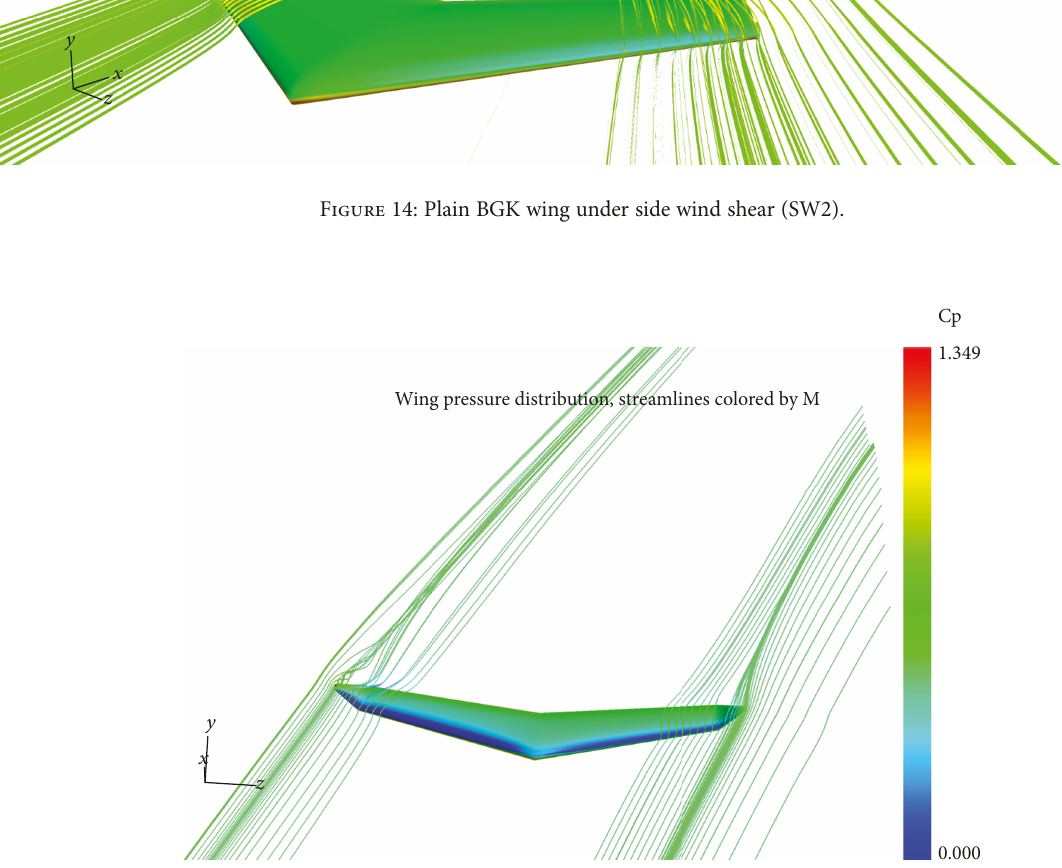
Figure 15: BGK wing with folding wing tip at 50 azimuthal points at the wing surface would then expand Figure 22. For the 3D mesh on the complete aircraft model (rather than the re fl ection plane model), the mesh about the re fl ection plane is simply copied over towards the other side. The re fl ection plane then simply becomes a contiguous boundary between the two halves of the complete model. For each wing surface then, there were 53 spam wise points on the solid wing surface and 24 points from the wing tip to the far spanwise boundary. In the chordwise sense, the wing stretched from the trailing edge at point 32 on the lower sur- face towards the leading edge and back to the trailing edge at chord point 134. The fi rst 31 points were thus reserved for the wake. Normal to the wing, the mesh traversed fi nd grid at the surface and stretched and curved towards the re fl ection plane boundary. The fuselage stretched from point 15 on the lower surface to point 151 on the top surface. The fi rst 15 points in each direction described the model support. The